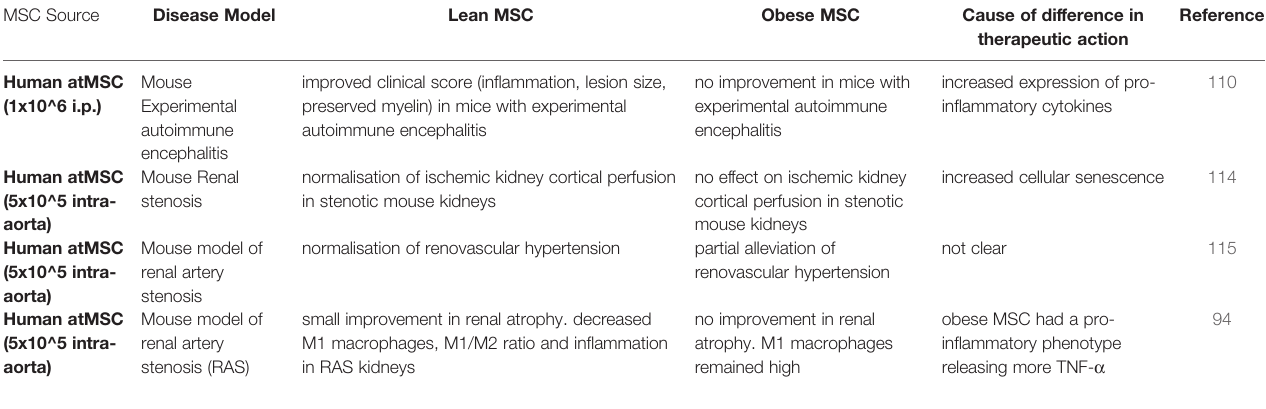
TABLE 3 | Studies comparing lean versus obese MSC therapeutic ef fi cacy in disease models. MSC Source Disease